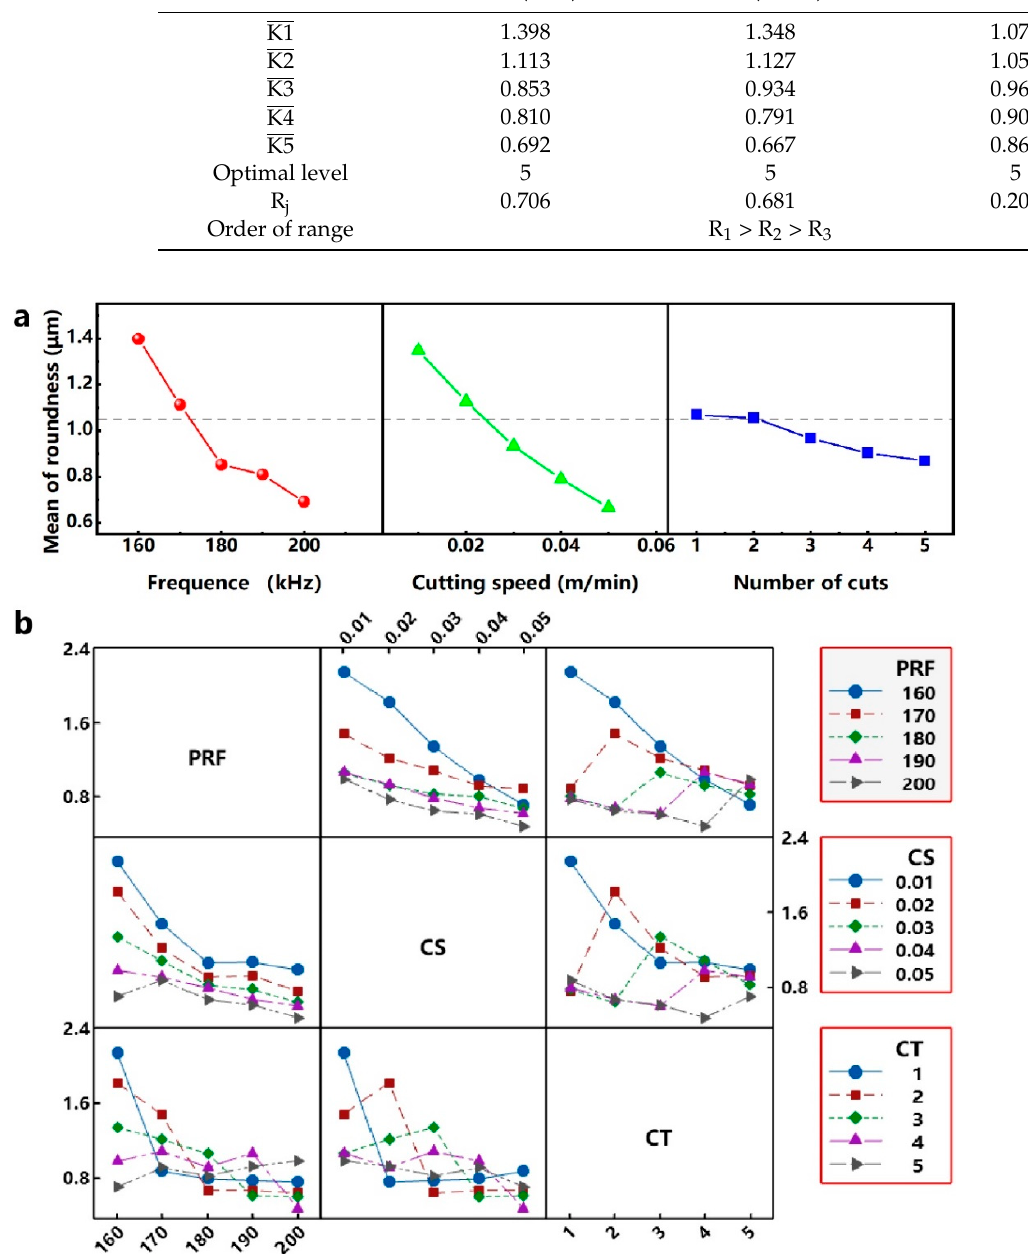
Figure 4. ( a ) Effect of process parameters on roundness. ( b ) Interactions between each parameter for roundness.